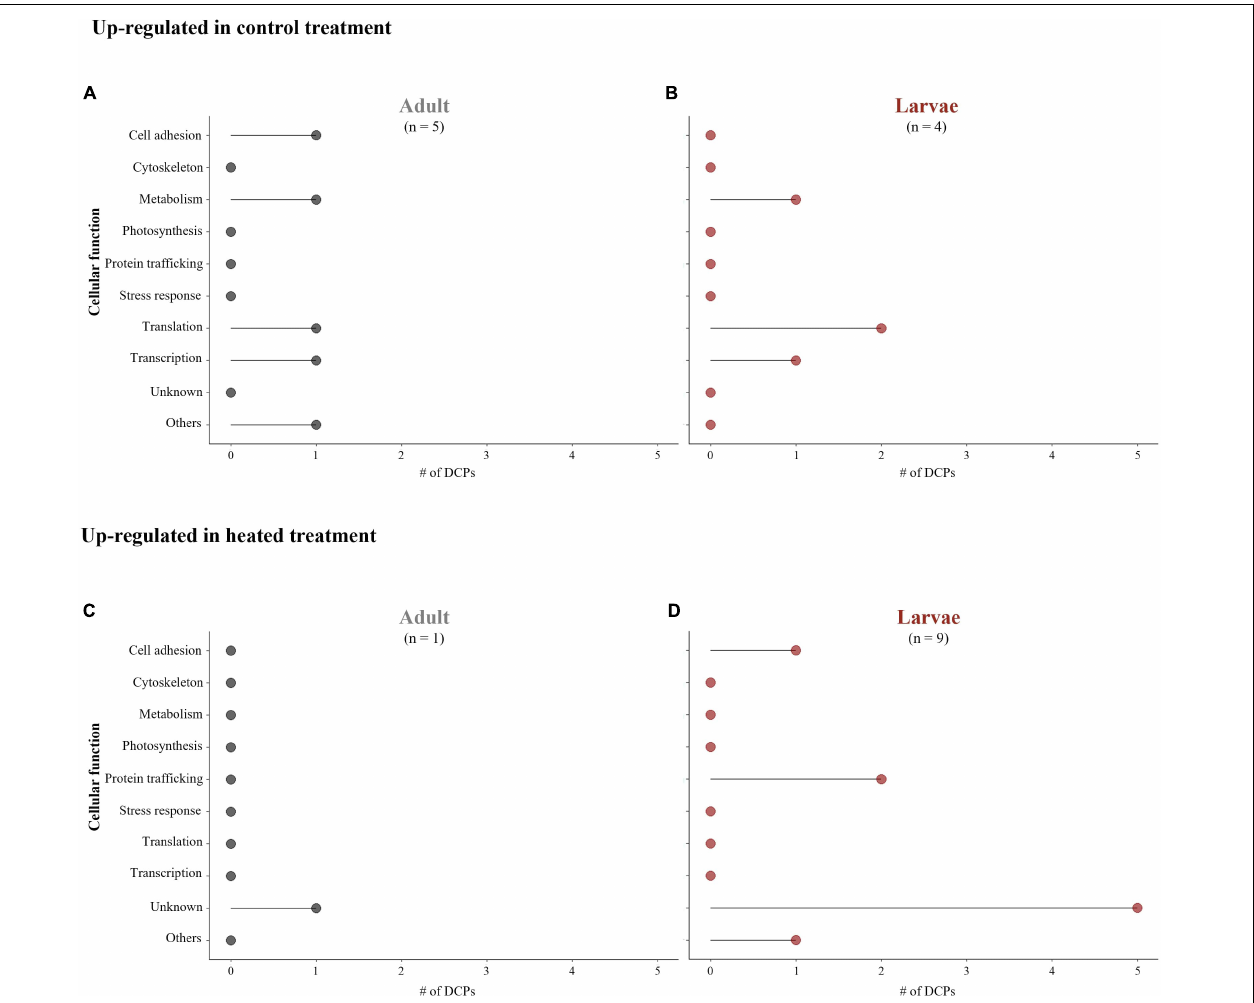
FIGURE 3 | Comparison of differentially concentrated proteins (DCPs) and their associated cellular function in Pocillopora acuta adults (A,C) and larvae (B,D) ; (A,B) DCPs up-regulated in the control treatment; (C,D) DCPs up-regulated in the heated treatment.